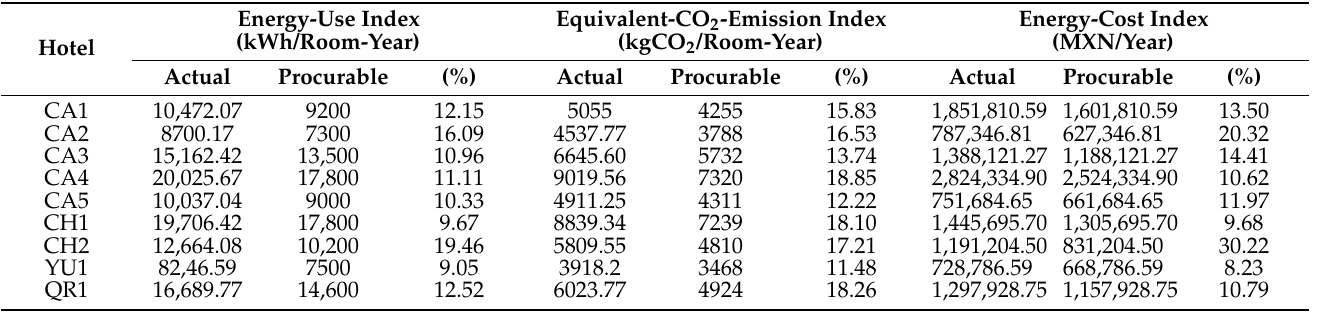
Table 7. Analysis of the behavior of indicators according to the percentage of